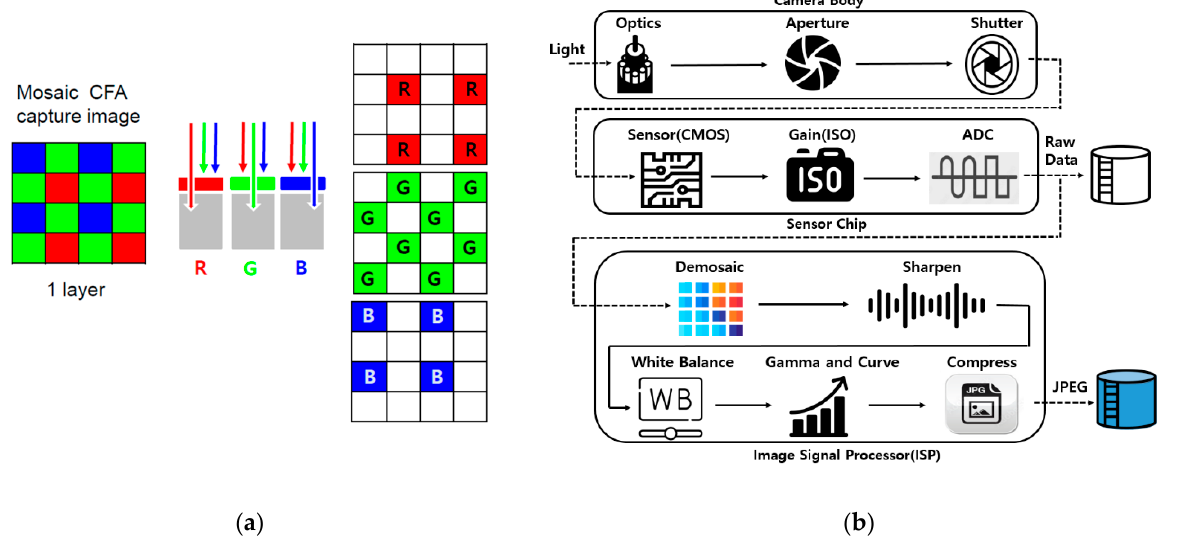
Figure 3. ( a ) Conventional mosaic capture CMOS sensor CFA technology. Color filters are applied to a single layer of pixel sensors, and make a mosaic pattern. Only one wavelength of R, G, or B passes through a pixel, and one color is recorded. ( b ) Schematic of the color image pipeline for making raw data image and jpeg image. Each stage of an image pipeline is fairly standard; although, varying in order.